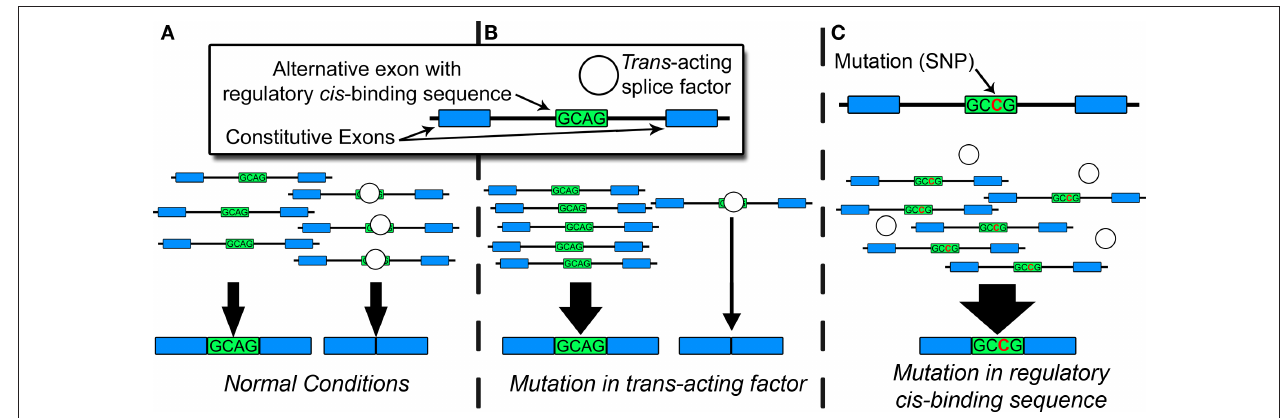
for the cis-regulatory sequence, resulting in changes in spliceoform quantities for multiple target RNAs. (C) Mutation in regulatory cis-binding sequence